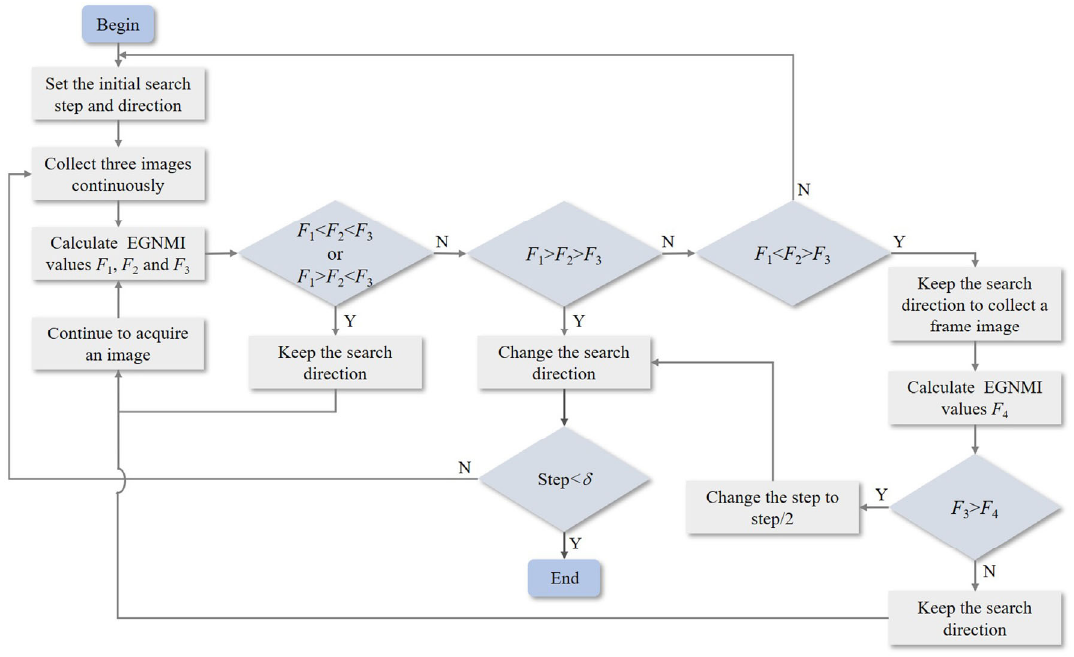
Figure 4. Improved hill-climbing search strategy fl owchart.